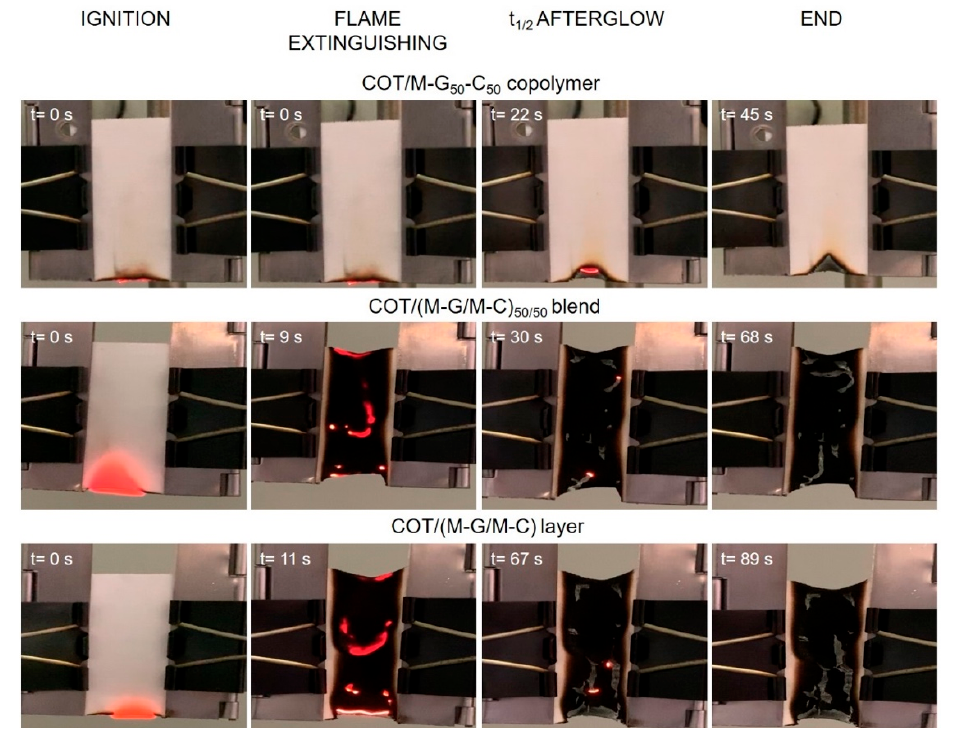
Figure 5. Snapshots of untreated, cotton fabrics trated with M–G 50 –C 50 copolymer (add-on: 16.0%), (M–G/M-C) 50/50 blend (add-on: 16.5%), and M–G/M–C layer (add-on: 16.1%) in vertical flame spread tests.